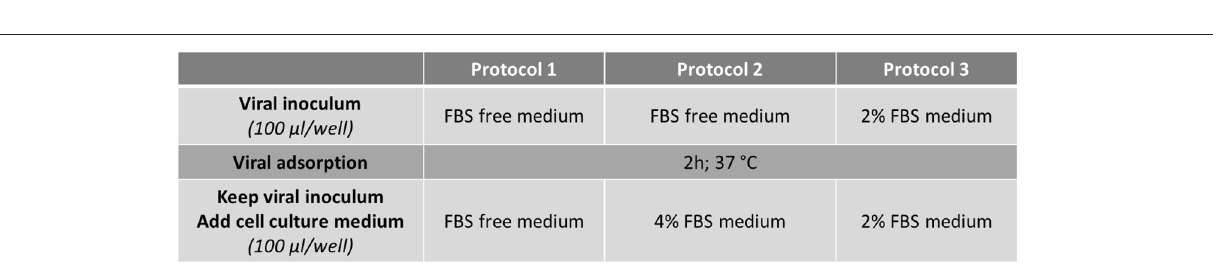
FIGURE 2 | Flowchart of the three infection protocols tested for the monitoring of HAV-induced cytopathic effect in FRhK-4 cells by using Real-Time Cell Analysis